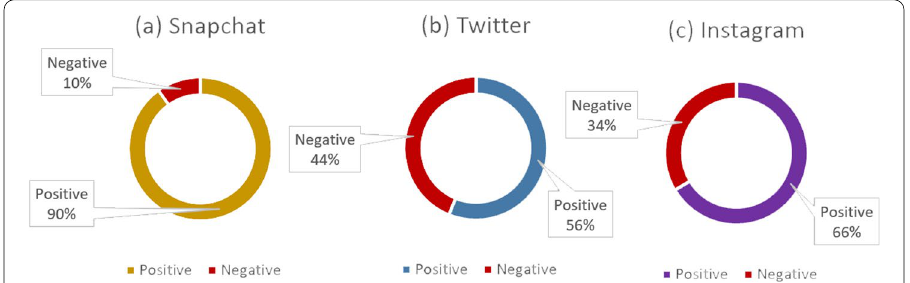
Fig. 9 The percentage of positive against negative opinions in all